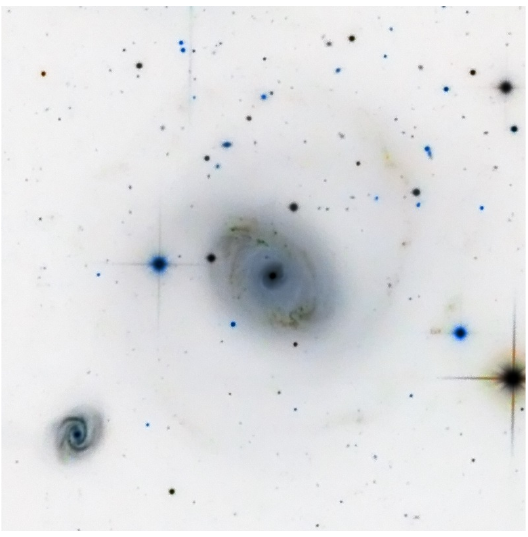
Fig. 1. Image of the Seyfert galaxy NGC 4151 taken by the Hubble Space